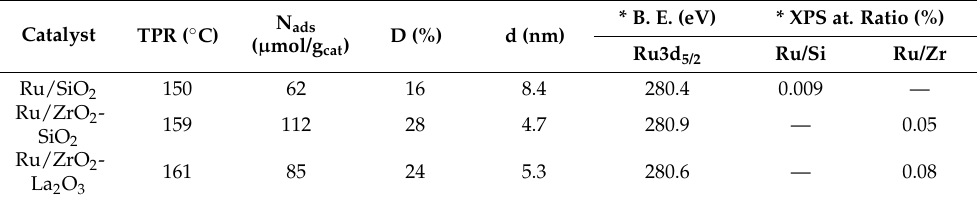
Table 5. TPR data (temperature of the maximum peak of the TPR profile); CO microcalorimetry (adsorbed amounts: N ads ; dispersions: D; mean Ru particle sizes: d) and XPS data (Ru3d 5/2 Binding Energy and XPS atomic ratios) for the supported Ru